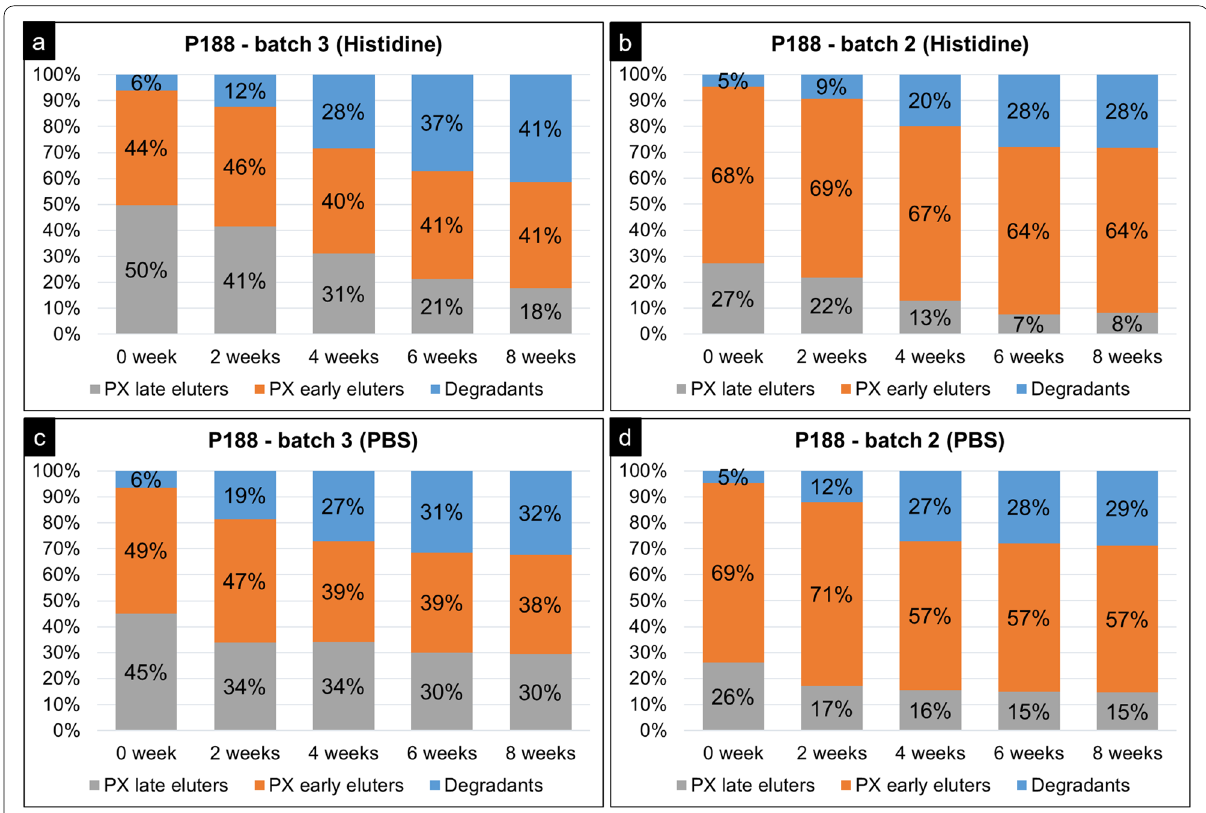
Fig. 6 The degradation of P188 at 60 °C in histidine ( a , b ) and PBS buffers ( c , d